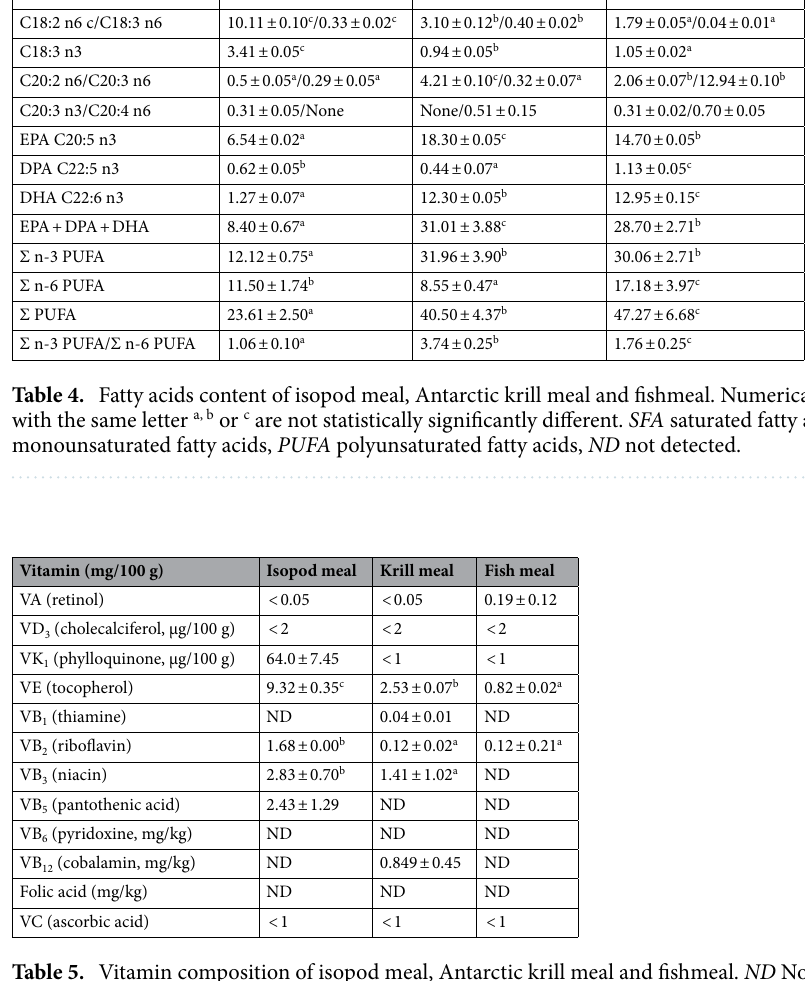
Table 5. Vitamin composition of isopod meal, Antarctic krill meal and fishmeal. ND Not Detected. Values with the same letter a, b or c indicates that the differences are not statistically significant between mean values at the p < 0.05